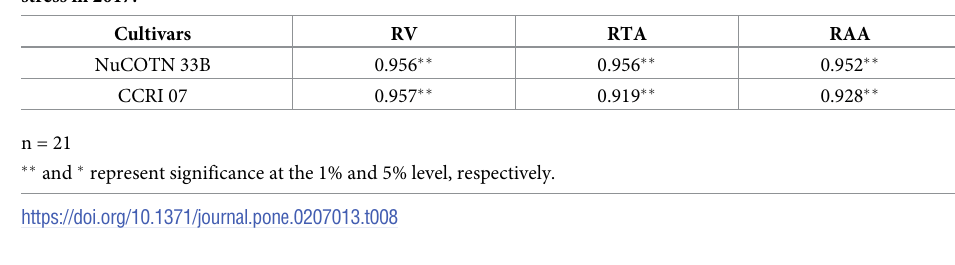
Table 8. Correlation coefficients between roots physiological indexes and Bt protein content under soil salinity stress in